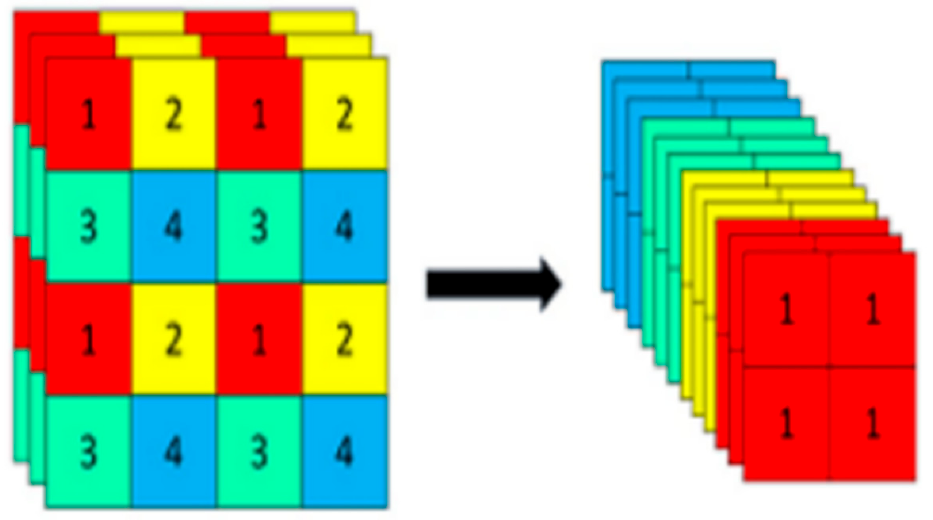
Figure 2. Focus structure. The red color represents the first three channels, the yellow and green colors represent the middle six channels, and the blue color represents the last three channels. Numbers represent sequence of the colors.